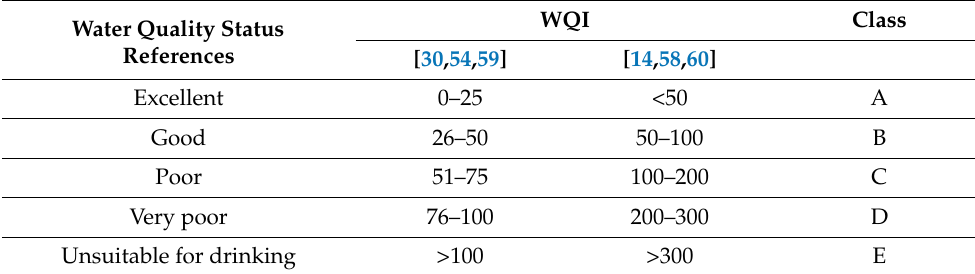
Table 3. Different water quality scales for WAWQI method